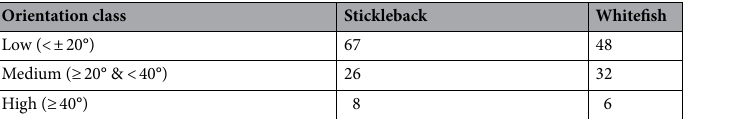
Table 3. Number of stickleback and whitefish in each of the orientation different orientation classes, measured as absolute degrees relative to the water